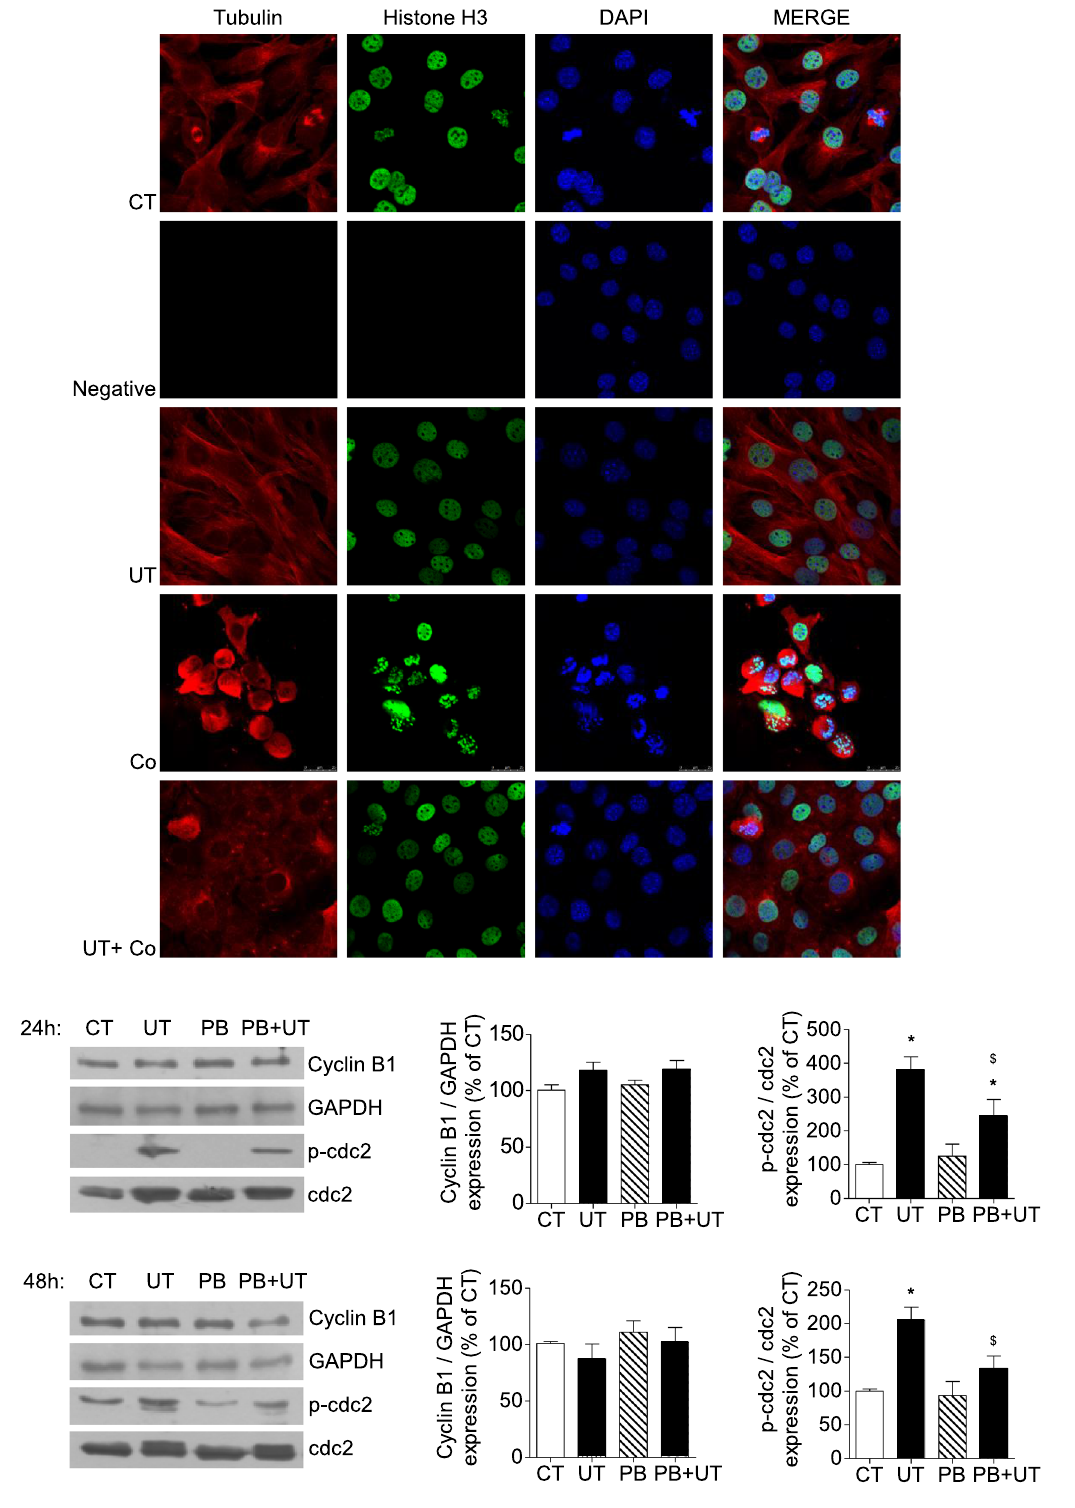
Figure 2. High doses of UT prevented entry into phase M promoting cdc2 phosphorylation and inactivating the Cyclin B/cdc2 complex. ( a ) C 2 C 12 cells were treated with a mixture of 100 µg/mL IS and 100 µg/mL PC (UT) for 24 h in the presence or absence of 0.1 mg/mL colcemid (Co). Tubulin (red) and Histone H3 (green) expression and DAPI (blue) were analysed by immunofluorescence by using a confocal microscope. A representative experiment with negative staining control is shown. ( b ) C 2 C 12 cells were incubated with a mixture of 100 µg/mL IS and 100 µg/mL PC (UT) or vehicle (CT) for 24 or 48 h in the presence or absence of 0.25 mM probenecid (PB). Cyclin B and phospho-cdc2 and cdc2 expression were analysed by western blotting. Representative blots are shown. Full-length blots are presented in Supplementary Figure S3. Bar graphs represent the densitometric analysis of the bands. Results are expressed as a percentage of control and are the mean ± SEM from five experiments. * p < 0.05 versus CT. $ p < 0.05 versus